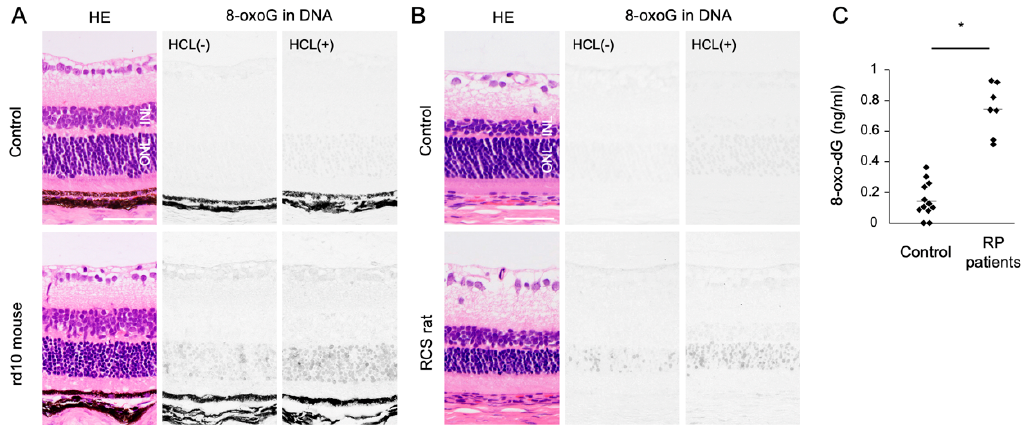
Figure 2. The Figure is reproduced from [16] with copyright permission. Accumulation of oxidative DNA damage in retinitis pigmentosa (RP). ( A ) and ( B ). Hematoxylin and eosin (HE) staining and immunohistochemical staining of 8-oxo-7,8-dihydroguannine (8-oxoG) in the retina of rd10 mice ( A ) and Royal College of Surgeons (RCS) rats ( B ), two genetically different models of retinitis pigmentosa. Per staining, HCl pretreatment was used to denature the nuclear DNA, thereby enhancing the detection of 8-oxoG in the nuclear DNA. Note that 8-oxo-G accumulation is substantially increased in the outer nuclear layer (ONL) of RP mice. Scale bar, 50 μ m. INL: inner nuclear layer. ( C ) Enzyme- linked immunosorbent assay for 8-oxo-dG in the vitreous of RP patients and controls (patients with idiopathic epiretinal membrane). The vitreous levels of 8-oxo-dG are increased in RP patients. * p =